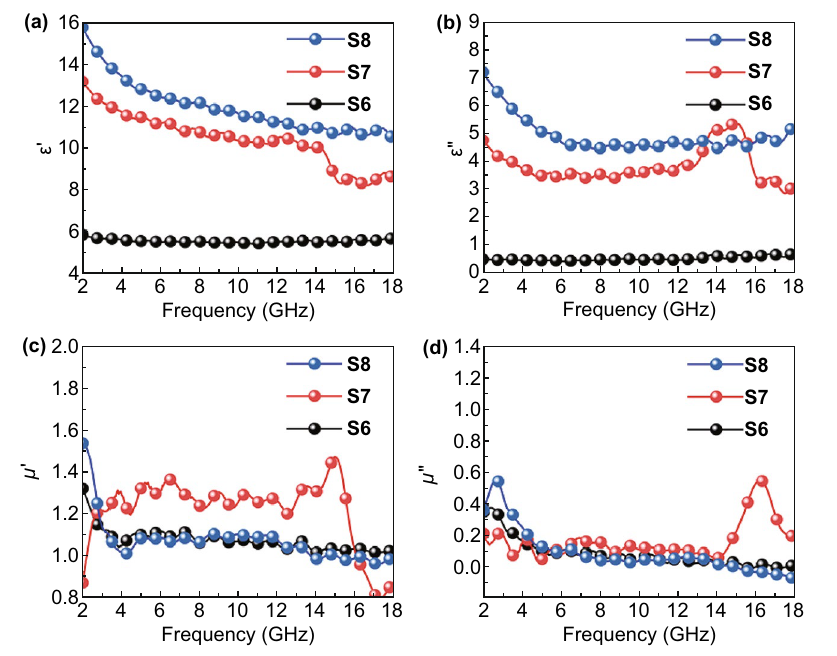
Fig. 4 Frequency dependences of a real and b imaginary parts of complex permittivity, c real and d imaginary parts of complex permeability for the S6, S7, and S8 at the frequency range of 2–18